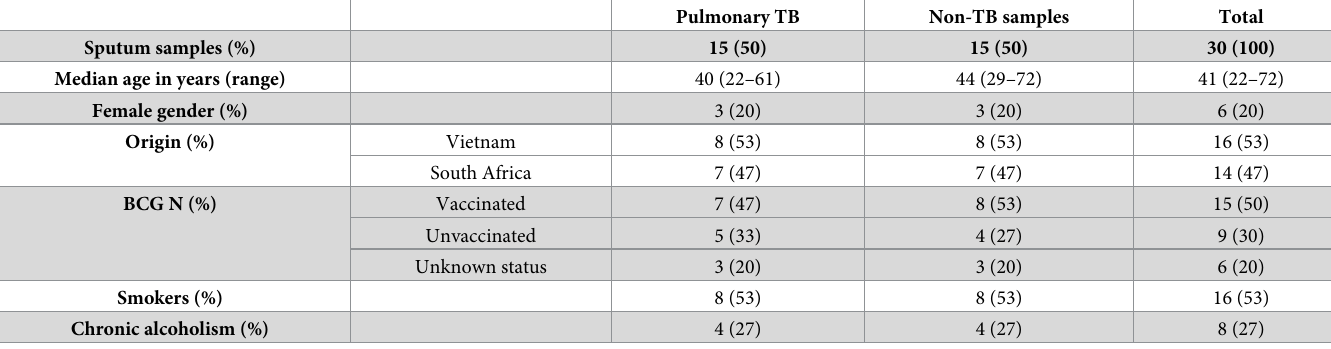
Table 2. Characteristics of the second batch of samples received from FIND.